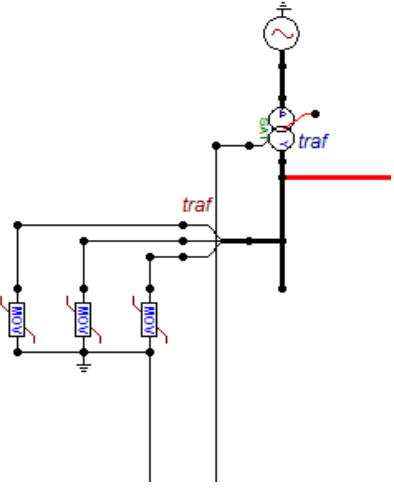
Figure 8. Installation of SPD at DCS building electrical incoming.